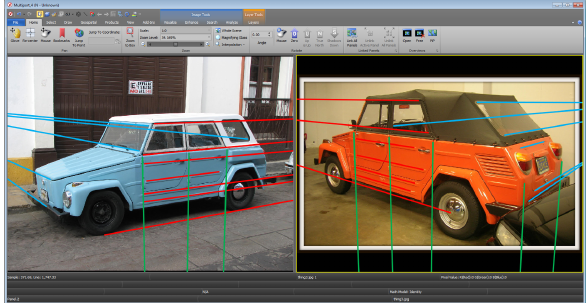
Figure 7. Two Volkswagen Things, viewed in 3-point perspective, with ground-parallel lines marked. Z is chosen as the dimension most into the image, completing a right-handed coordinate system with X towards image-right, and Y towards Figure 6. Simulated reprojection error for various configurations of measurement error and vanishing line segments. The error depicted in Figure 5 is the baseline case at the intersection of the three curves.